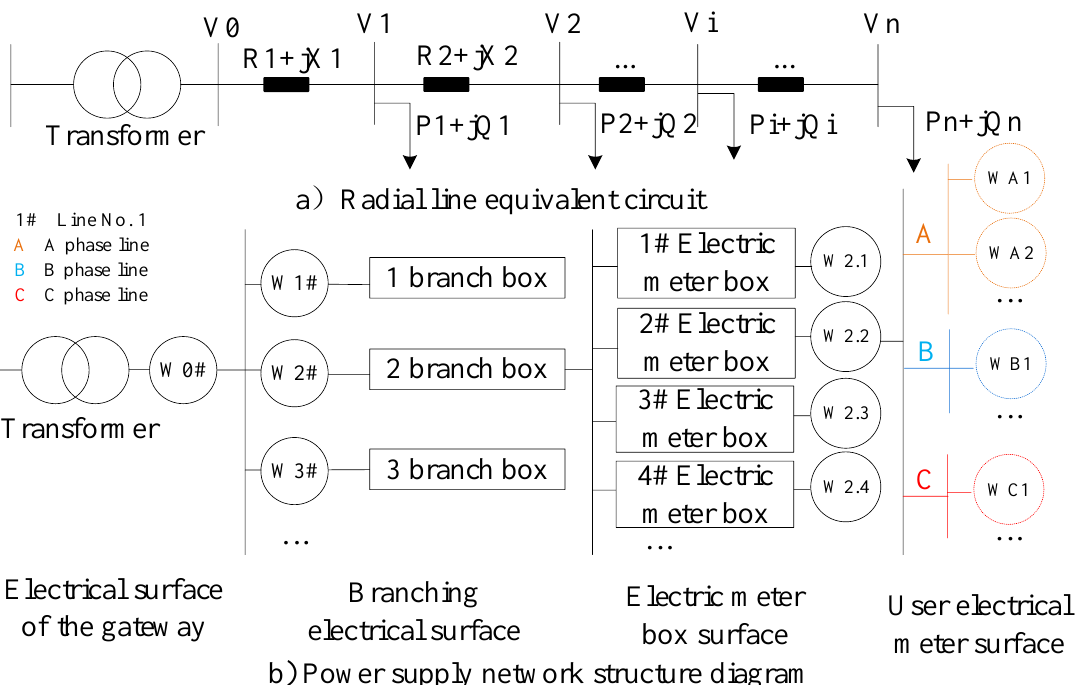
Figure 3. Topology equivalent circuit of substation area.